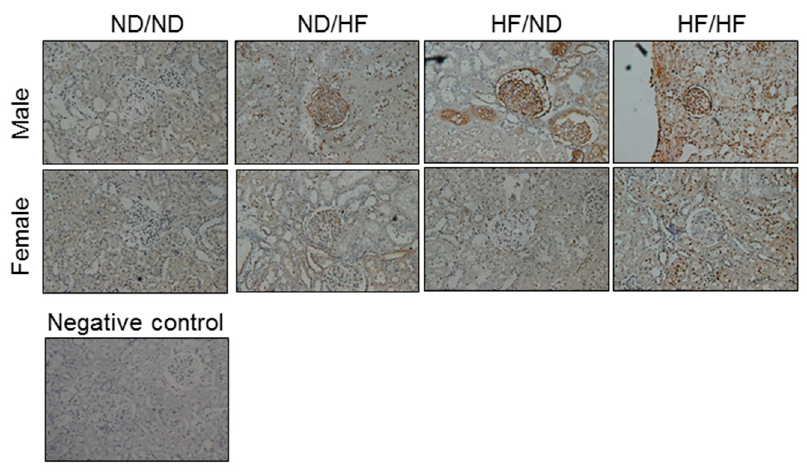
Figure 4. Light micrographs illustrating immunostaining for 8-OHdG in the offspring kidney (400 × ).